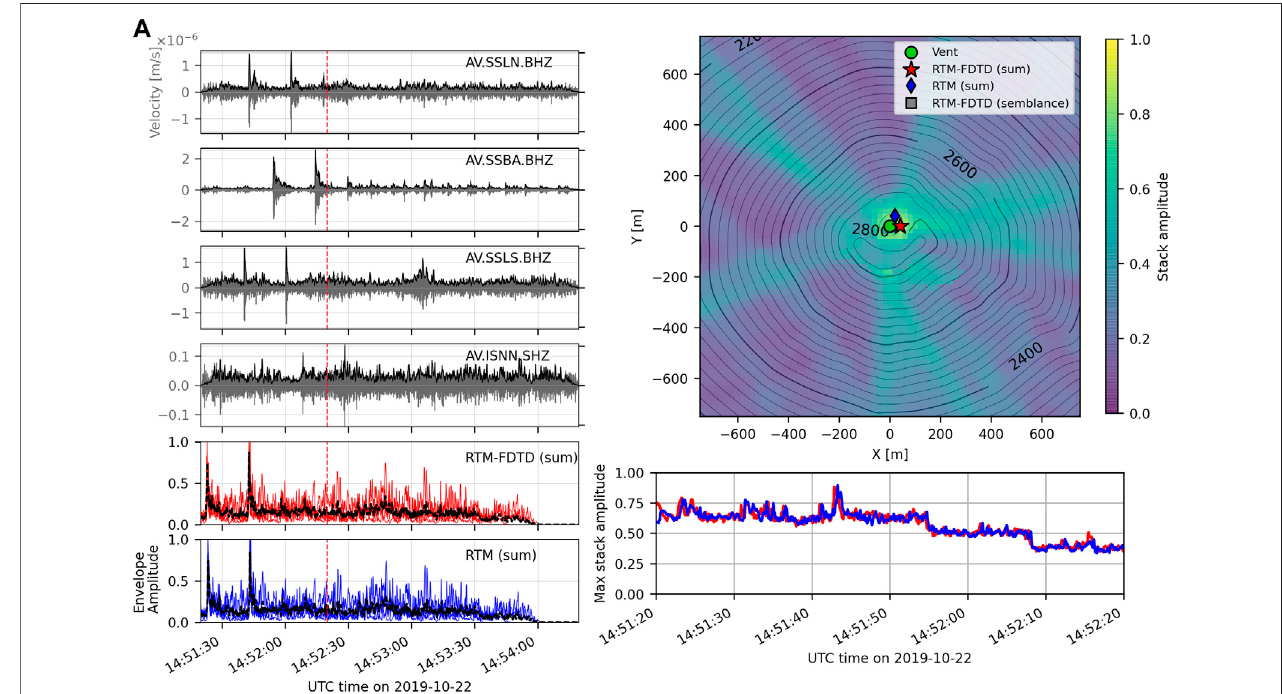
FIGURE8| Shishaldinexplosionwaveformsandlocationcomparison.Figurelayoutisthesameasin Figure3 ,exceptwaveformsare fi lteredbetween5and15 Hz and these are seismic data. RTM (sum) and RTM-FDTD (sum) produce similar results and locate the source to within 50 m of the base of the crater, while RTM-FDTD (semblance) does not provide a realistic location due to poor